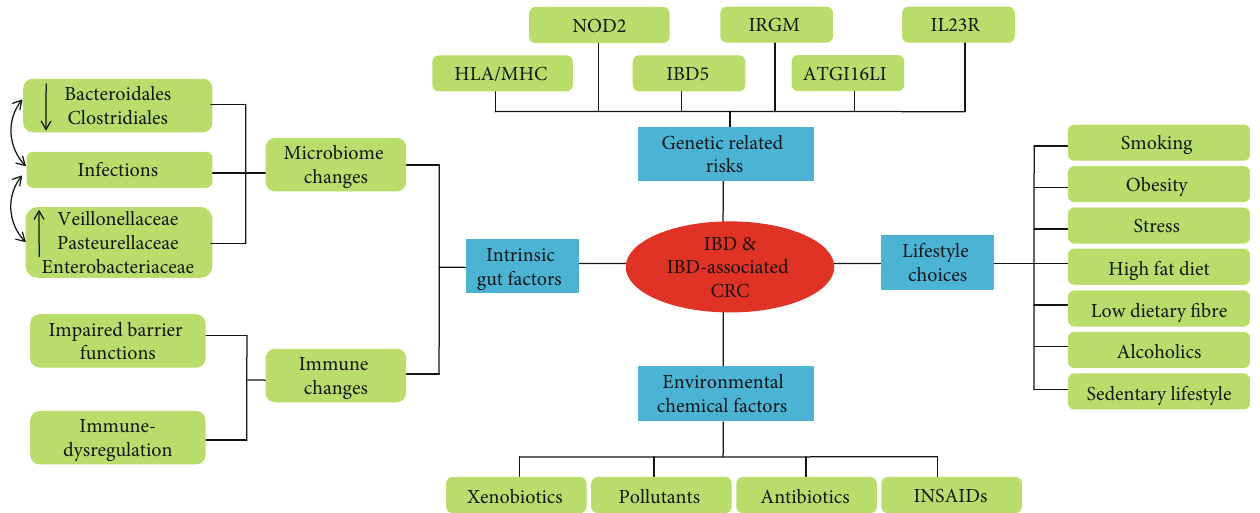
Figure 2: Risks factors associated with the unset and development of IBD/IBD-associated CRC. Though these factors mostly overlap, they can be put into four main categories which have many other subsets. NOD2: nucleotide-binding oligomerization domain-containing protein 2; HLA/MHC: Human Leukocyte Antigens/Major Histocompatibility Complex; IRGM: immunity-related GTPase family M protein; ATG16LI: authophagy-related 16-like gene; IL23R: interleukin 23 receptor; IBD5: In fl ammatory Bowel Disease